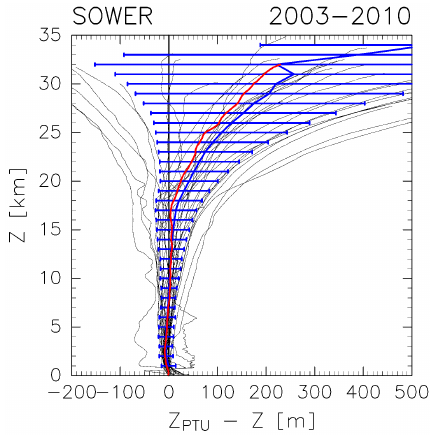
Figure A1. As for Fig. 1 but for profiles using non-QC data.